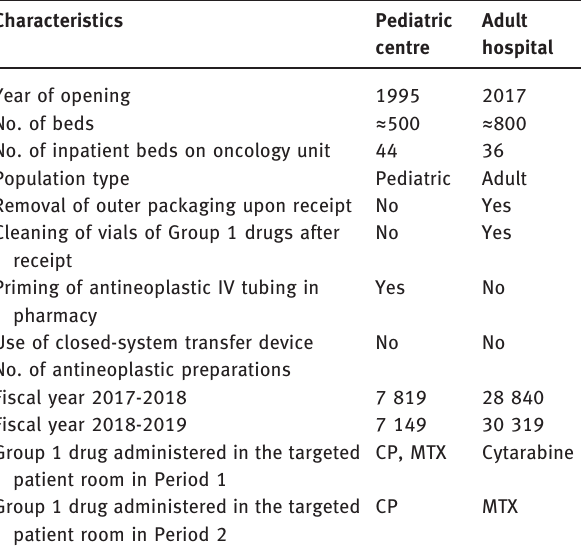
Table 1: Characteristics of the two study